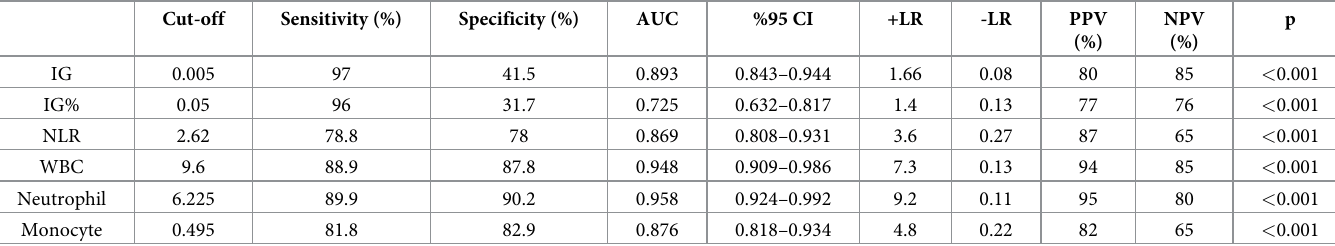
Table 4. Predictive evaluation of the best parameters to show diagnostic of disease. Cut-off Sensitivity